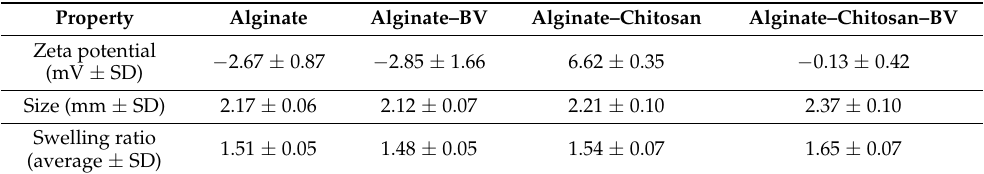
Figure 1. Brightfield images of the hydrogels swollen in PBS at 4×, the scale bar represents 1 mm. ( a ) Alginate hydrogel; ( b ) alginate hydrogel coated with chitosan; ( c , d ) SEM images of the dried hydrogels at different magnifications. Table 1. The properties of the hydrogel formulations. The zeta potential of the hydrogels, after being washed and resuspended in Milli-Q water ( n = 3/group, 10 runs each). The average size of 10 randomly selected spherical hydrogels. The average swelling ratio of the different hydrogel formulations (10 different hydrogels/group, selected at random).